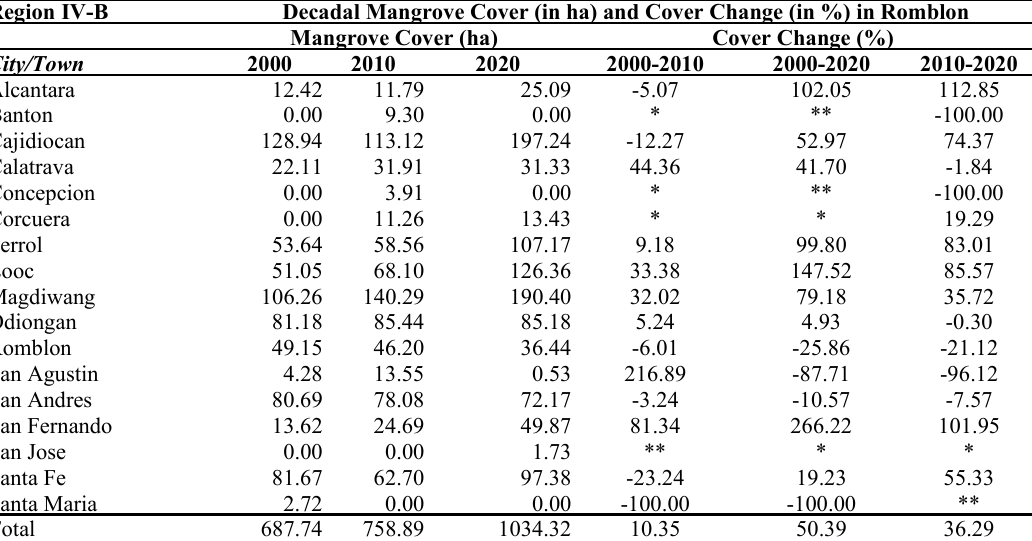
Table 6. Extracted Mangrove area (in ha) estimates in Romblon. Note: *percent change from 0 to a value. **percent change from 0 to